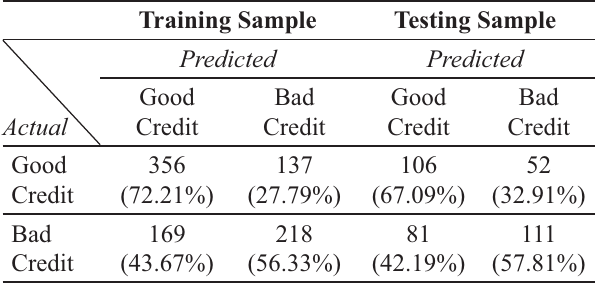
Table 1. Classifi cation results using discriminant analysis for training and testing